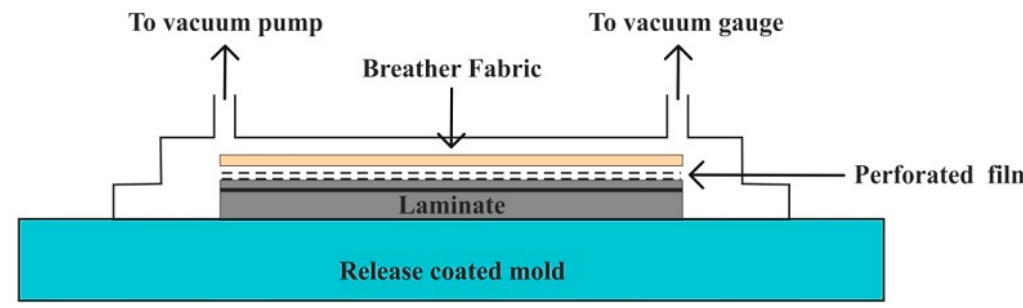
Figure 5. Vacuum bag molding process.